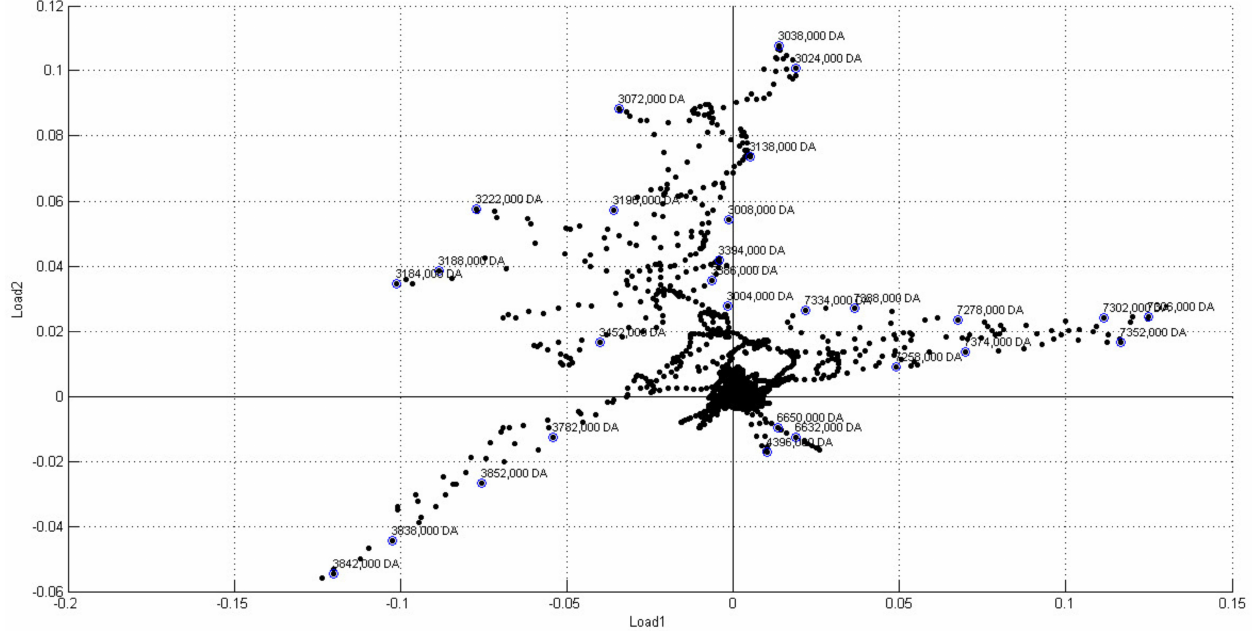
Figure 8. Load plot from Maldi Biotyper PCA Clustering analysis of infected and healthy C. sinensis leaves samples. The numbers indicate the ions